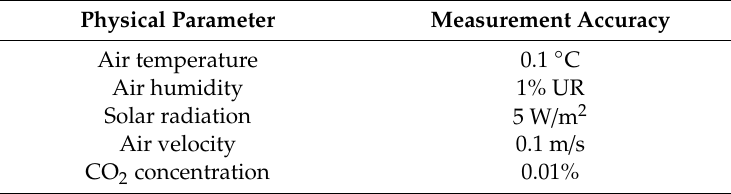
Table 1. Measurement accuracy for each physical